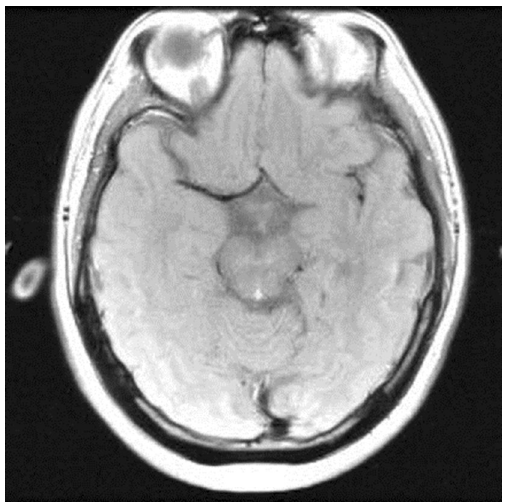
Figure 1. Standard reference brain image reconstructed using